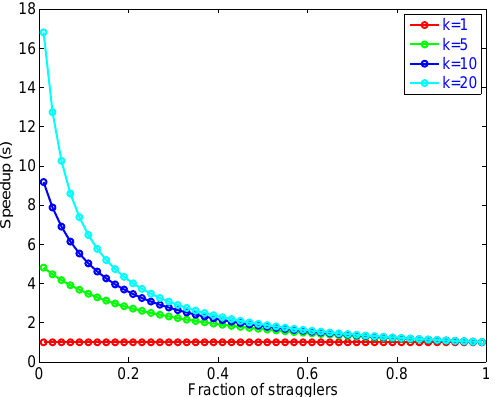
Figure 11. An illustration of speed-up in M / M / k limited by Amdhal’s